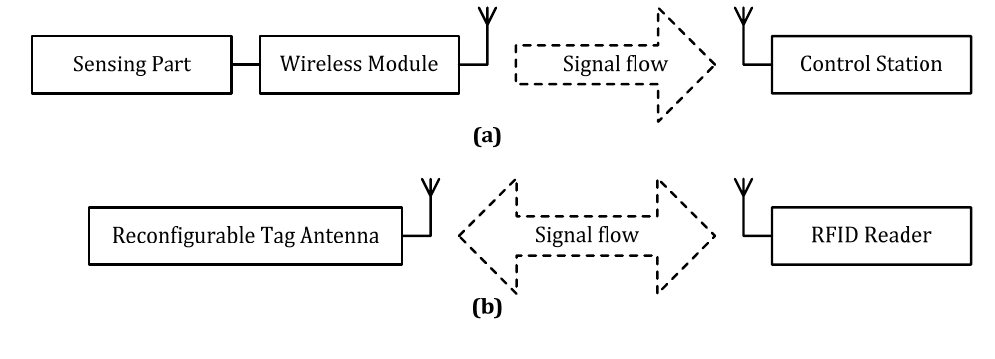
Figure 3. Sensor system ( a ) integrated with wireless module and ( b ) based on wireless